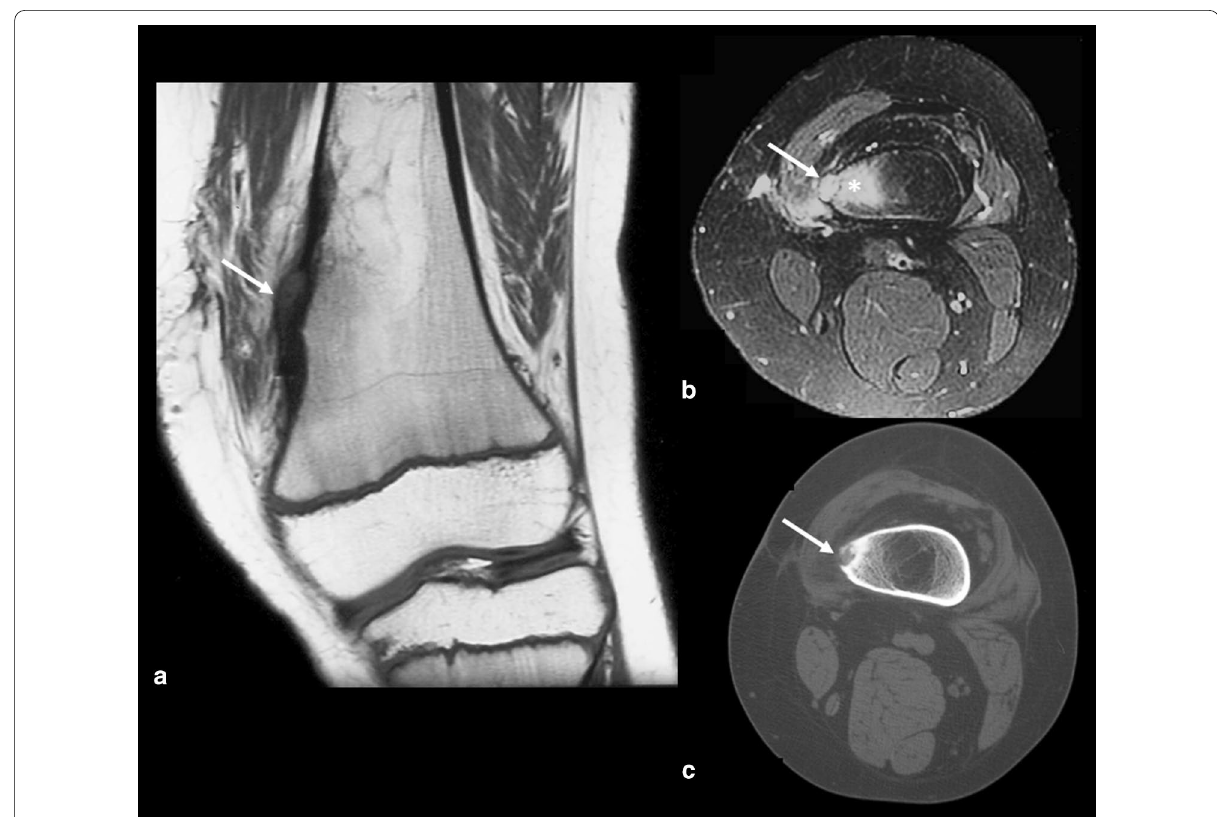
Fig. 6 Osteoid osteoma near a growth plate. An 11–year-old male with a history of surgical removal of an OO on the distal metadiaphysis of the left femur. His symptoms persisted, and follow-up MRI ( a , b ) and CT ( c ) showed a residual nidus at the medial femoral margin represented by the intracortical nodule (arrows) and surrounding bone marrow edema (asterisk in b ). In a, note that the affected side of the distal femur is longer than the lateral side, resulting in a femoral deformity and length discrepancy of the left lower